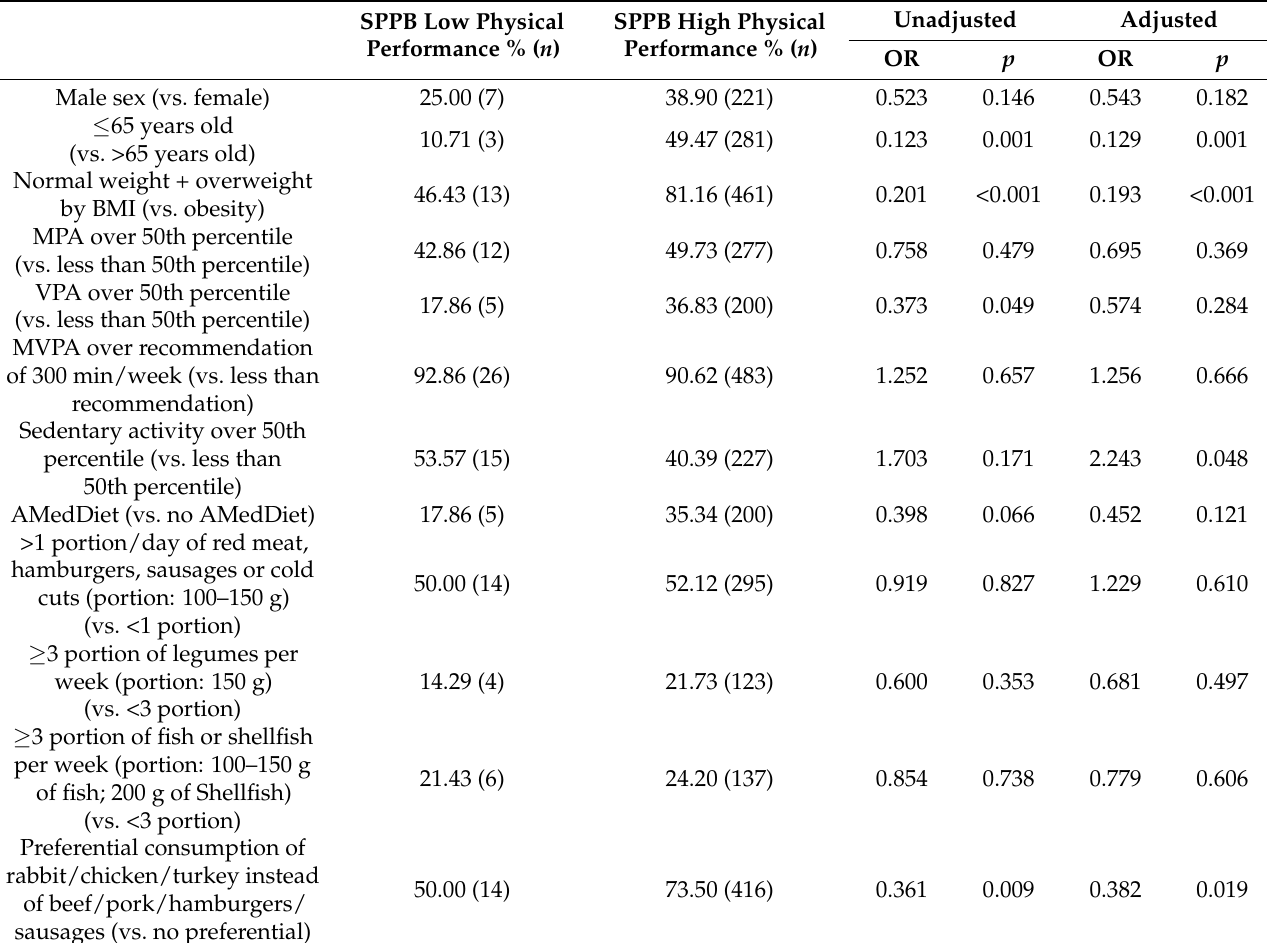
Table 7. Odds ratio of physical performance by SPPB unadjusted and adjusted by sex and